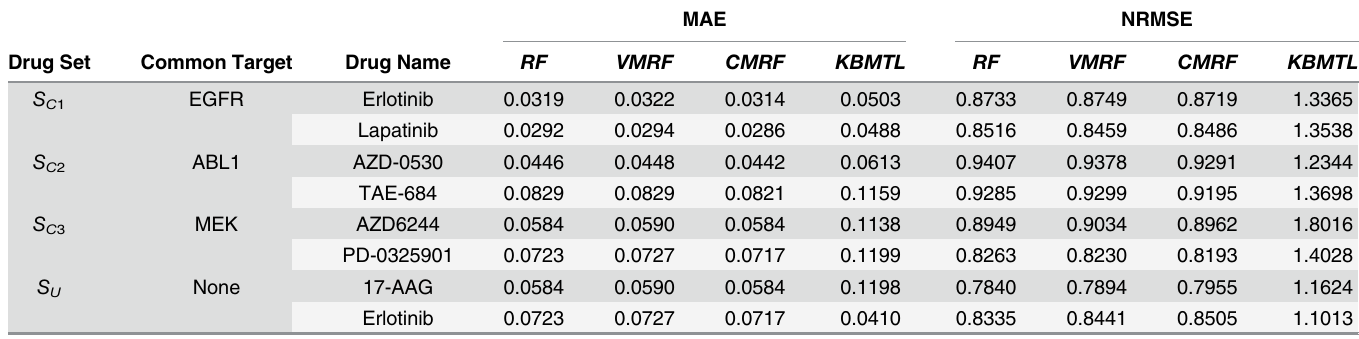
Table 4. 5 fold CV results for GDSC Dataset drug sensitivity prediction for four drug sets in the form of MAE and NRMSE for RF, VMRF, CMRF and KBMTL approaches. Drug Set Common Target